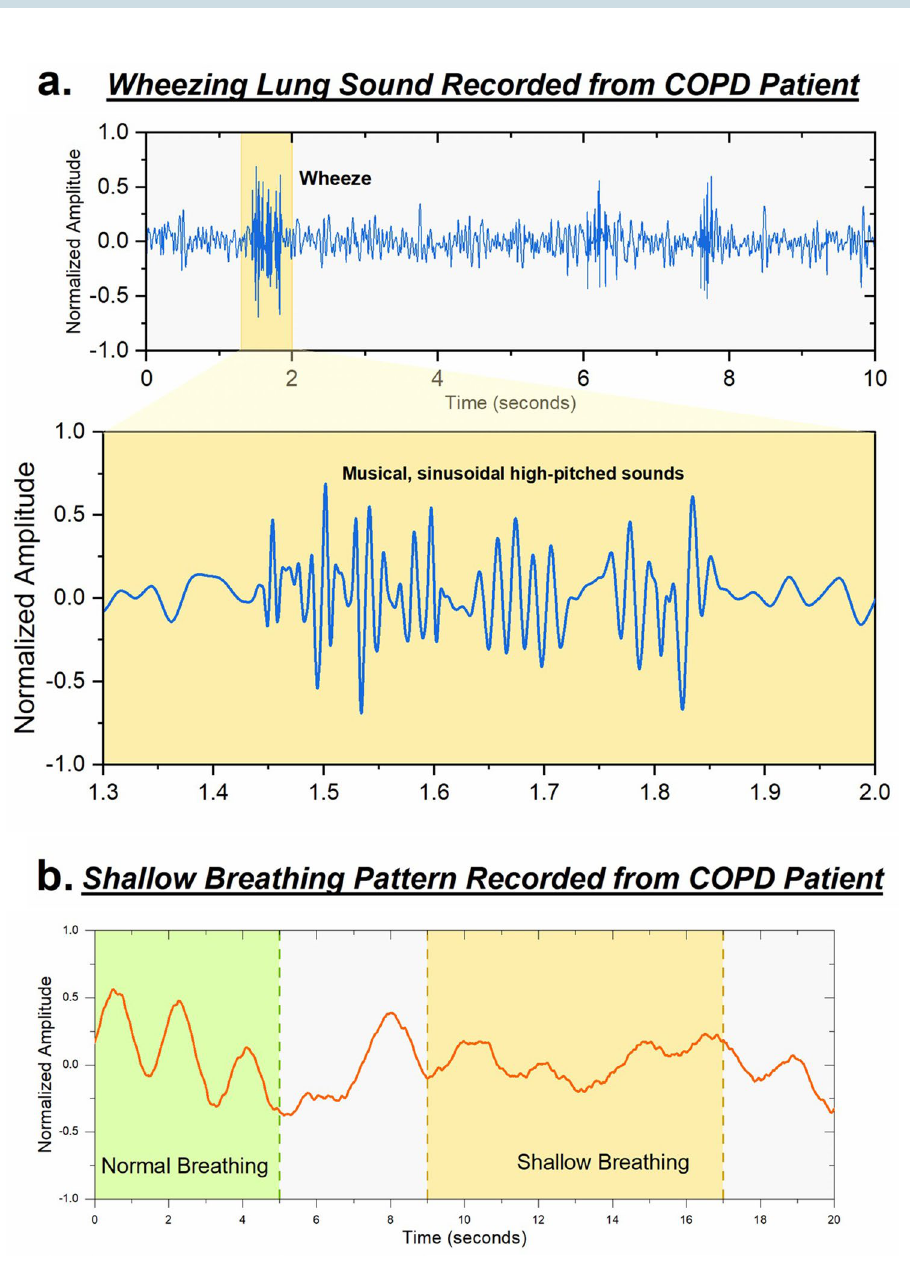
Figure 4. Pathological signals recorded from COPD patient. ( a ) Wheezing lung sound recorded from left upper lobe on the posterior side from patient with COPD. Wheezing periods are highlighted in the waveform. ( b ) COPD patient exhibiting difficulty in breathing, characterized by a shallow breathing